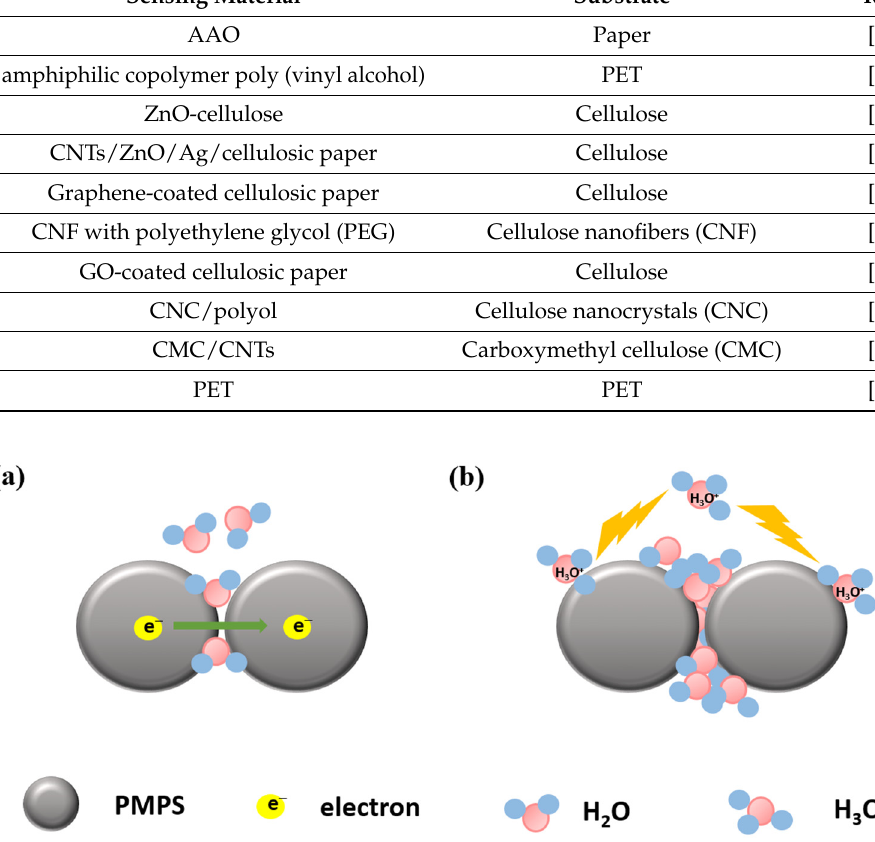
Table 3. The comparison of polymer based electrical type humidity sensors.